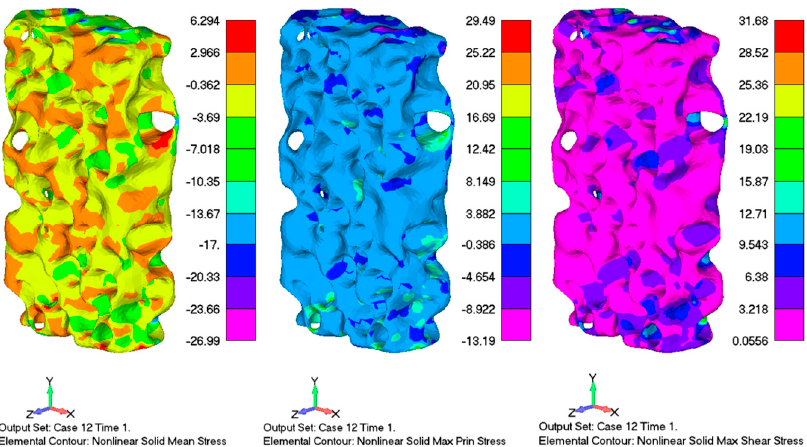
Figure 10. Stress contours of the numerical model under compressive load: Nonlinear solid mean stress ( left ); nonlinear solid maximum shear stress ( centre ); and nonlinear solid maximum principal stress ( right ).